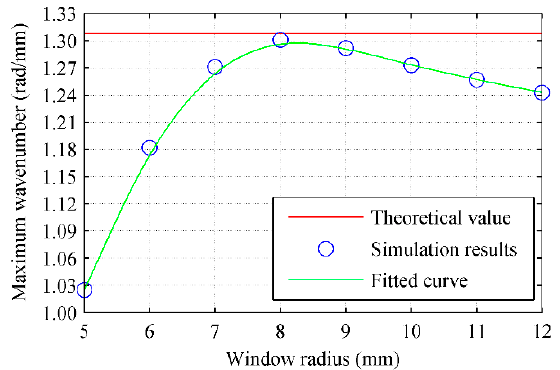
Figure 25. The maximum wavenumber obtained under various window radii. The central frequency of the excitation signal is 400 kHz.